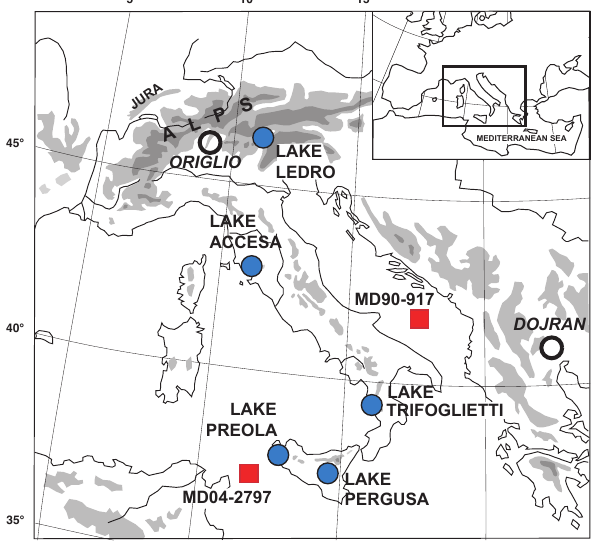
Fig. 1. Geographical location of the study sites corresponding to the contributions included in this special issue. Blue circles and red squares correspond to lake and marine records established within the LAMA project.